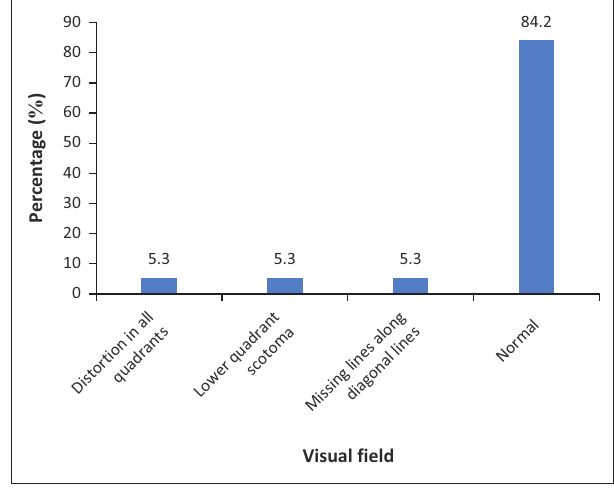
FIGURE 6: Visual field using the Amsler grid.